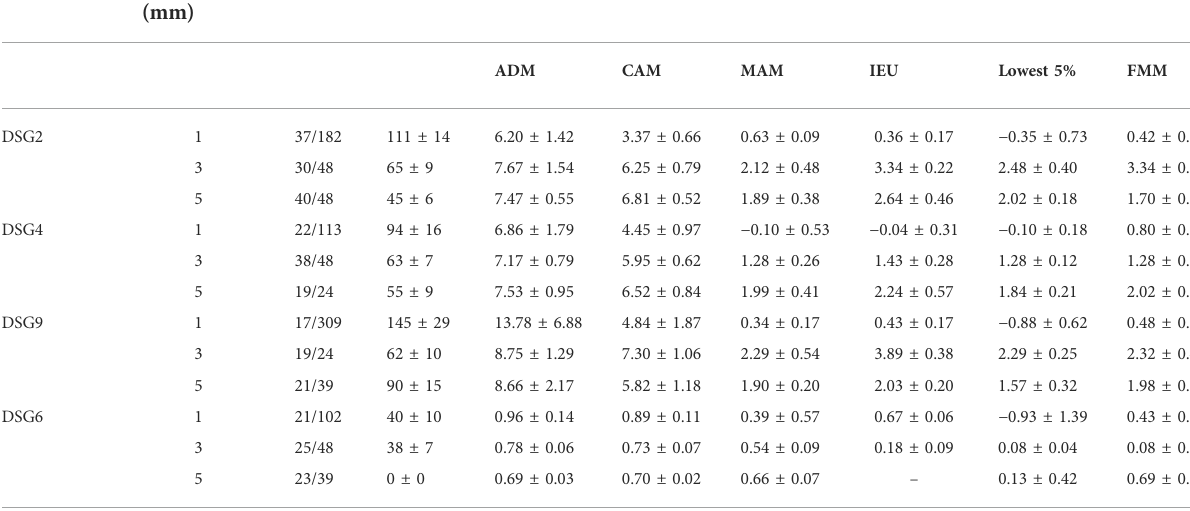
TABLE 1 Summary of equivalent doses and ages for different aliquot sizes and age models. Sample ID